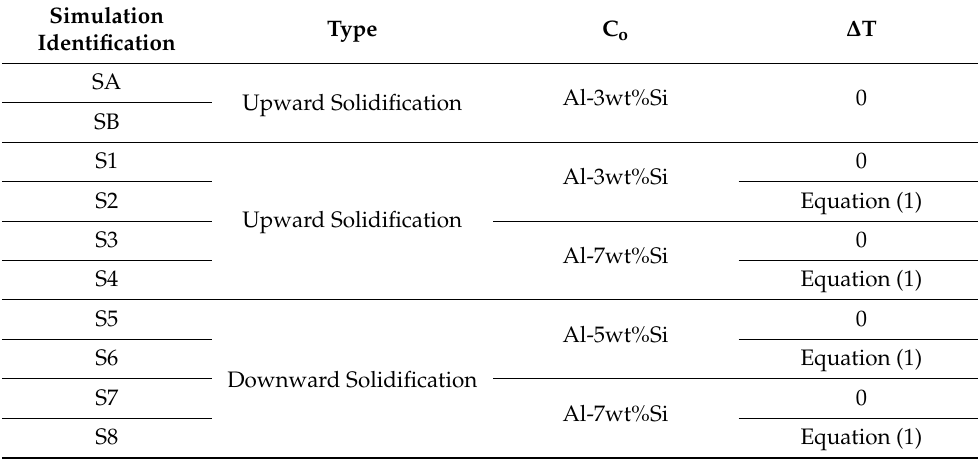
Table 3. Notations and details of the solidification